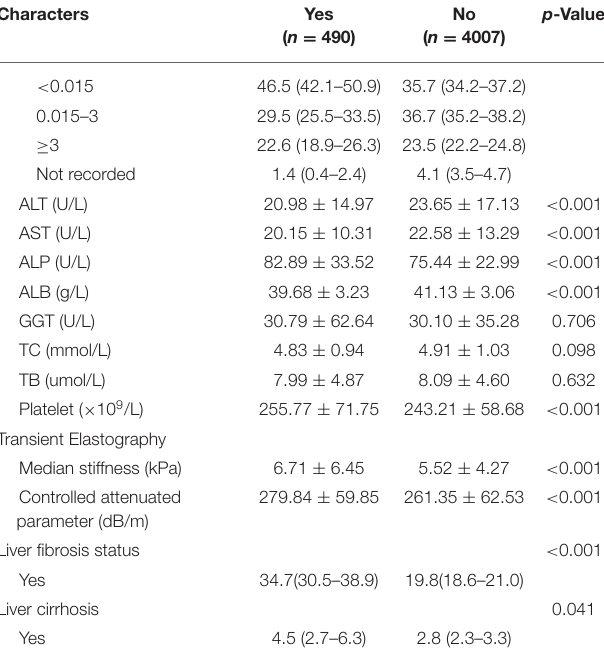
TABLE 1 | General characteristics of included participants ( n = 4497) by the presence or absence of a history of cholecystectomy in the NHANES